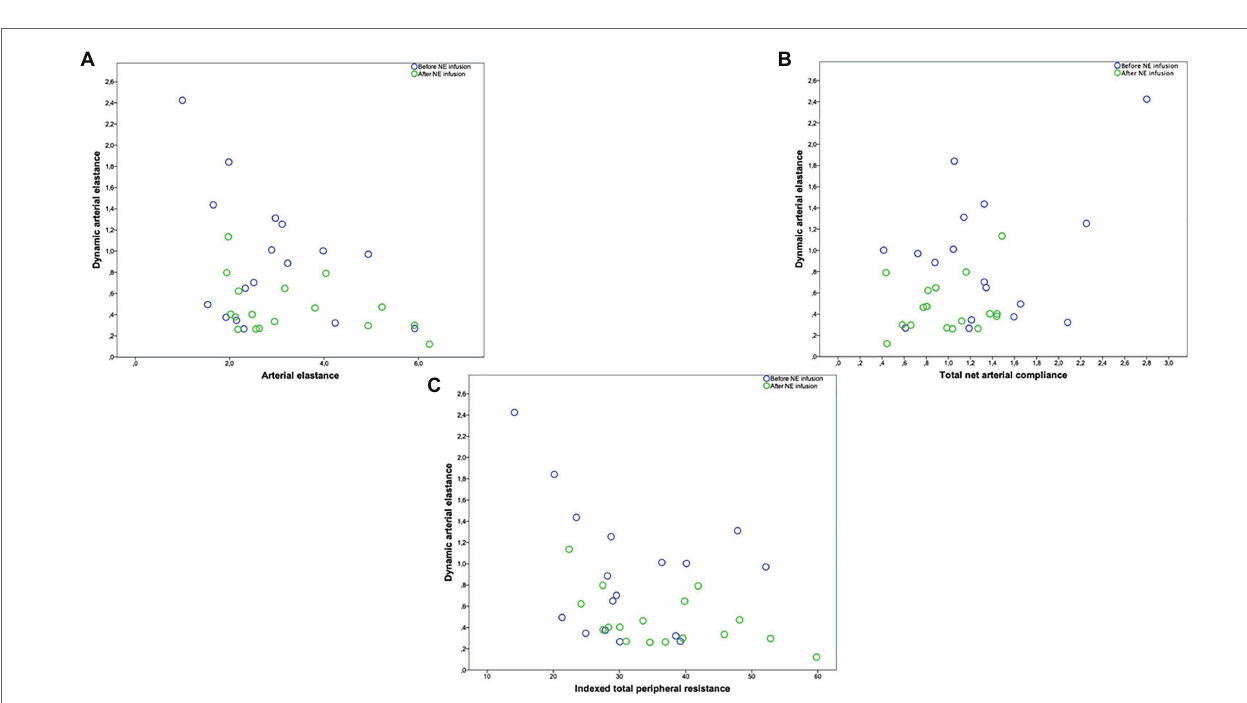
FIGURE 2 | (A) Relationship between dynamic arterial elastance and arterial elastance (mmHg ml −1 ·m −2 ). (B) Relationship between dynamic arterial elastance and total net arterial compliance (ml mmHg −1 ·m −2 ). (C) Relationship between dynamic arterial elastance and indexed total peripheral resistance (mmHg ml −1 ·m −2 ). Circle color refers to before (blue circle)/after norepinephrine (NE) infusion (green